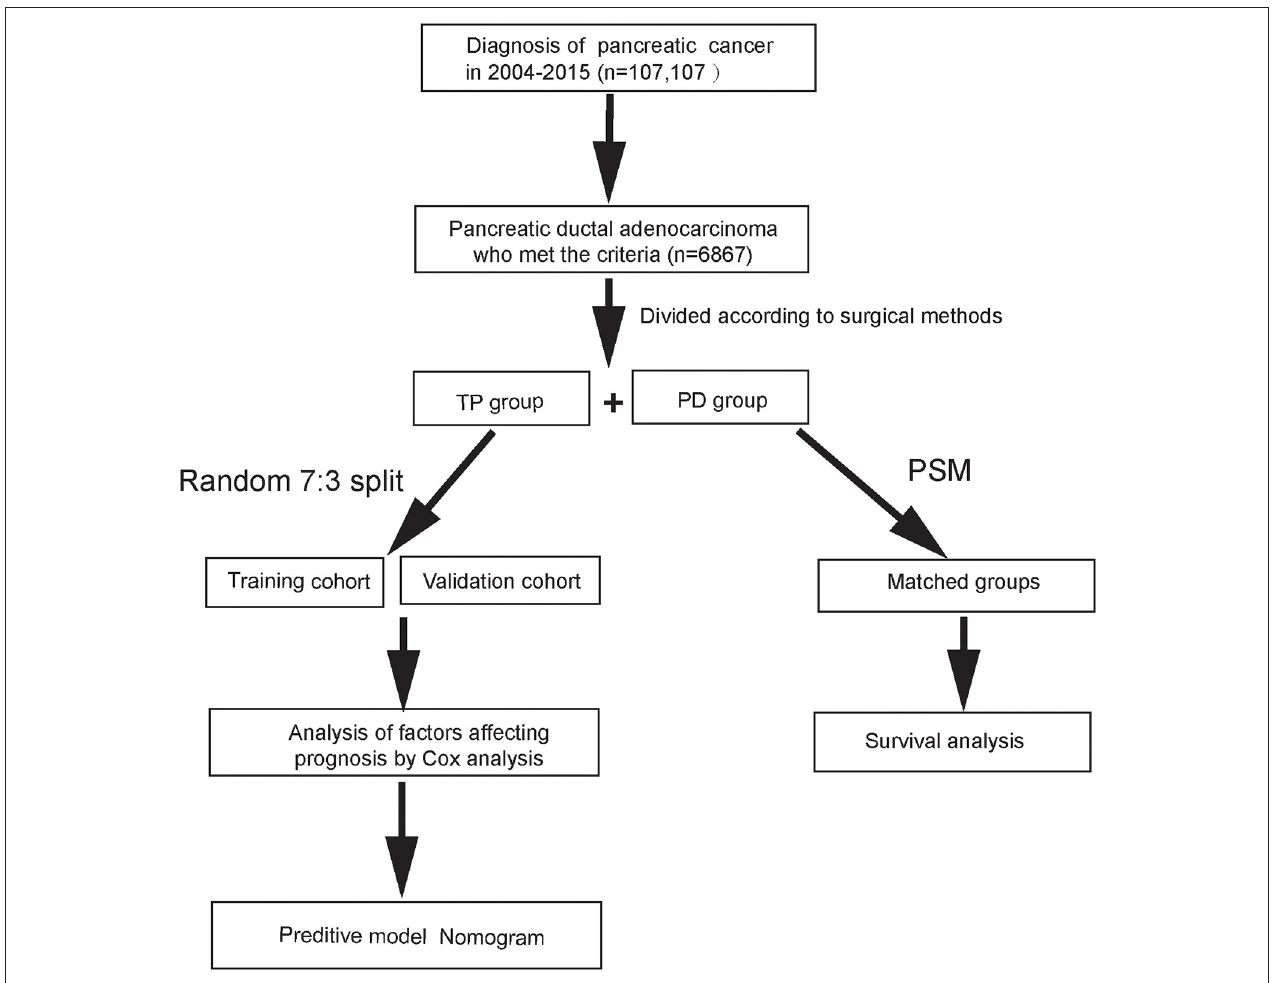
FIGURE 1 | Simple flow diagram of the